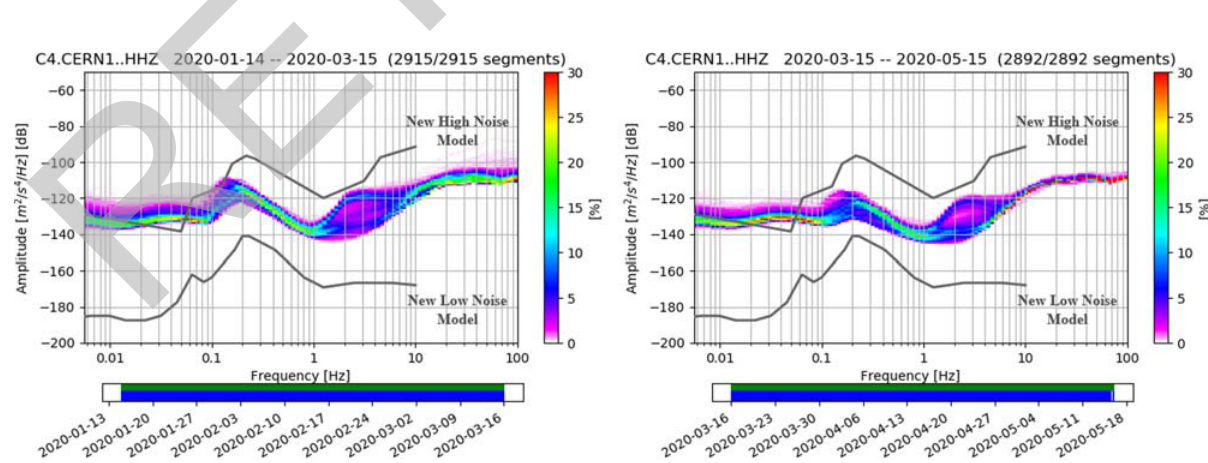
Figure 9: Probabilistic Power Spectral Density of CERN Seismic Station at Point 1 ( ATLAS ) calculated over a period of 2 months before ( left graph ) and 2 months after ( right graph ) the CERN COVID - 19